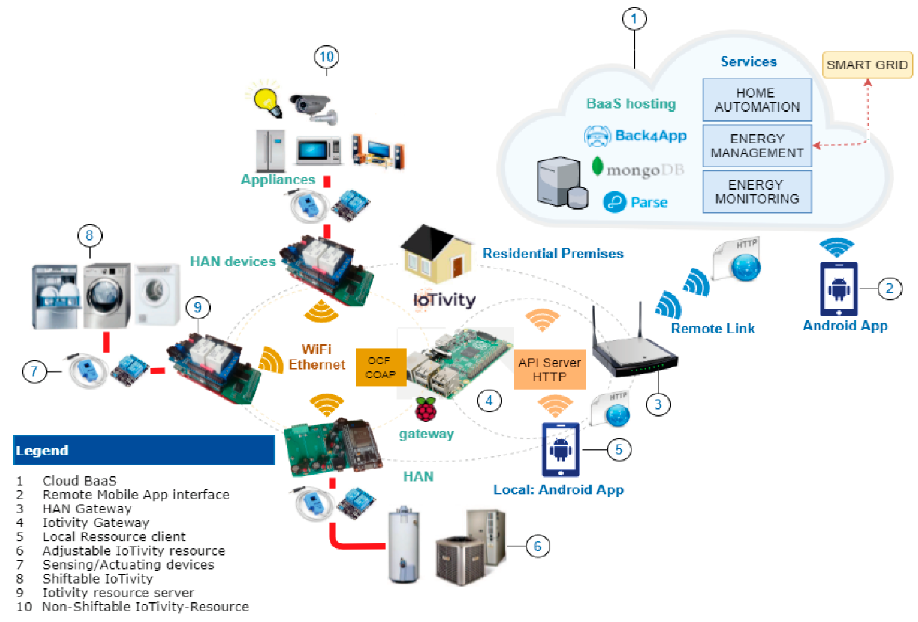
Figure 2 . Cloud-based IoTivity-Lite platform HEM architecture . Figure 2. Cloud-based IoTivity-Lite platform HEM